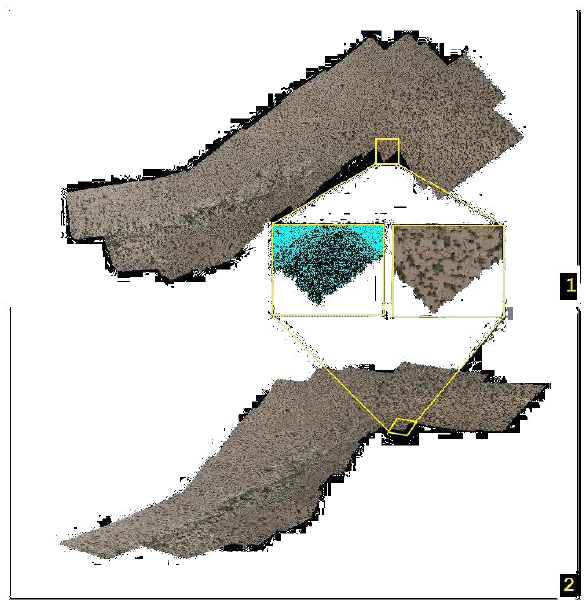
Figure 12: Two views of 3D model of Las Cruces test site (400 x 100 m): (1) is topview of terrain (2) is view from approximately 60 ◦ above horizon (insets show wireframe model and frame with draped images)